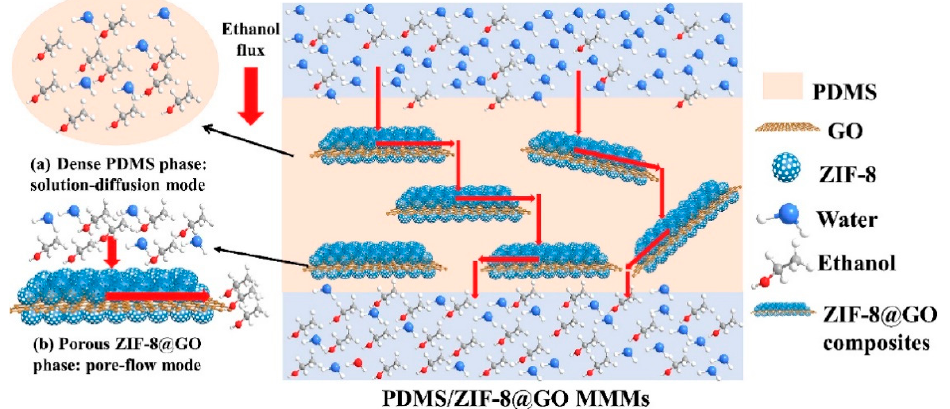
Figure 9. Schematic representation of mechanism of PDMS/ZIF-8@GO MMMs in ethanol